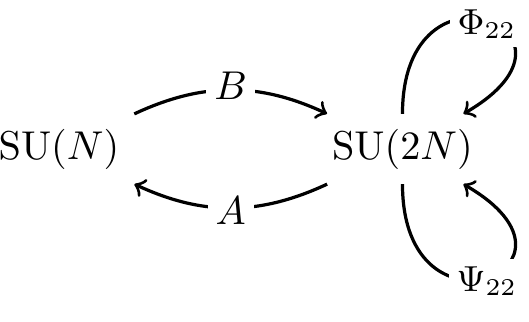
Figure 6 . Quiver for 4d Laufer’s